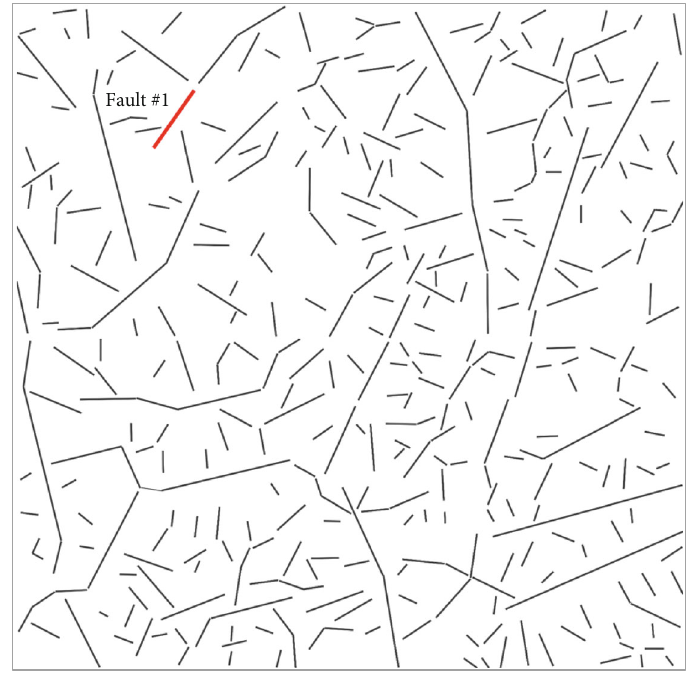
Figure 11: The fault model for the Ning209